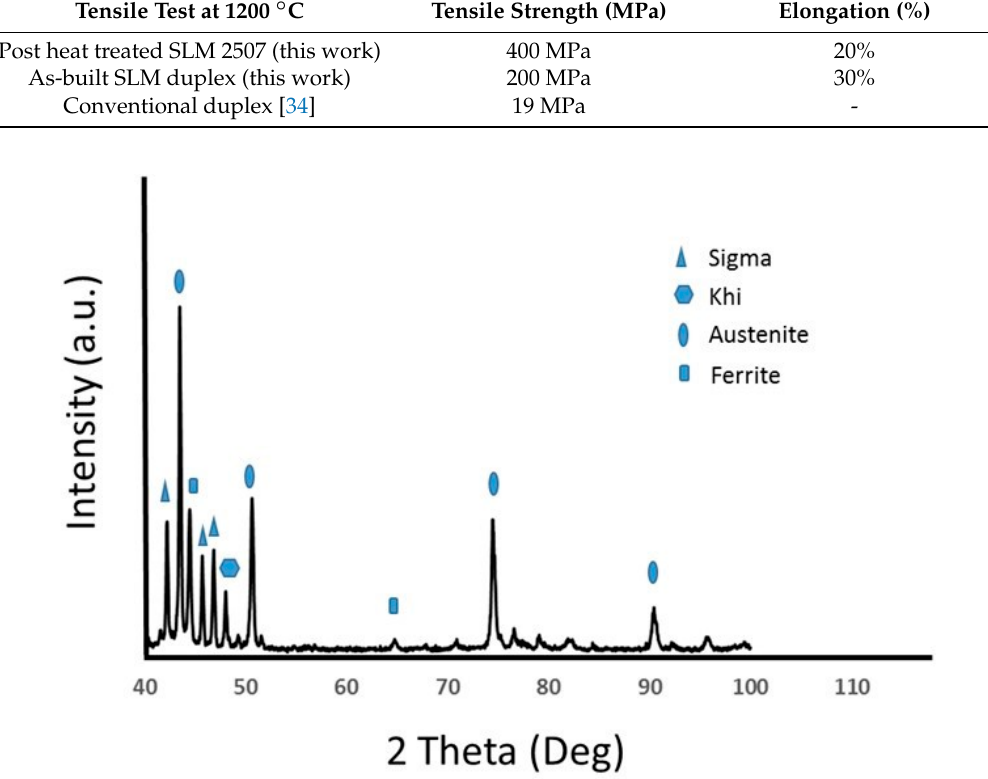
Figure 6. In-situ high temperature XRD phase analysis of SLM DSS 2507 taken at 1000 °C showing existence of ferrite, austenite and intermetallic sigma phase.